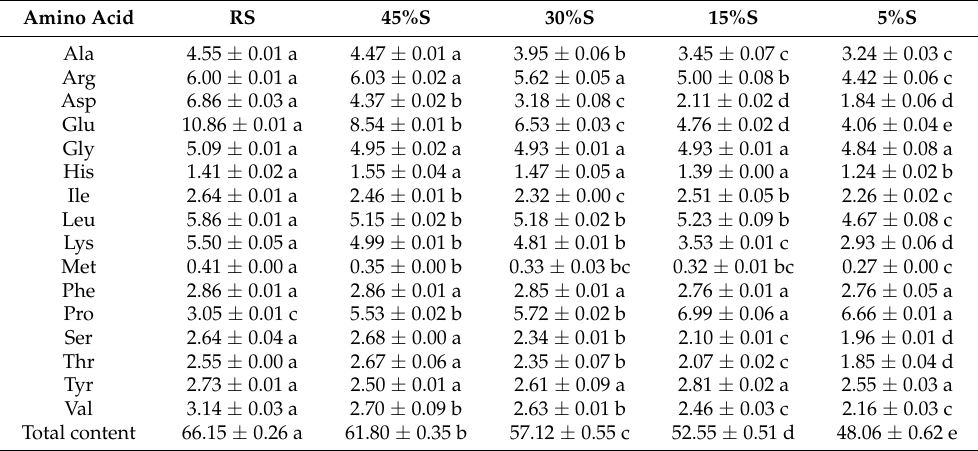
Table 2. Amino acid contents of shrimp (g/100 g sample, dry weight